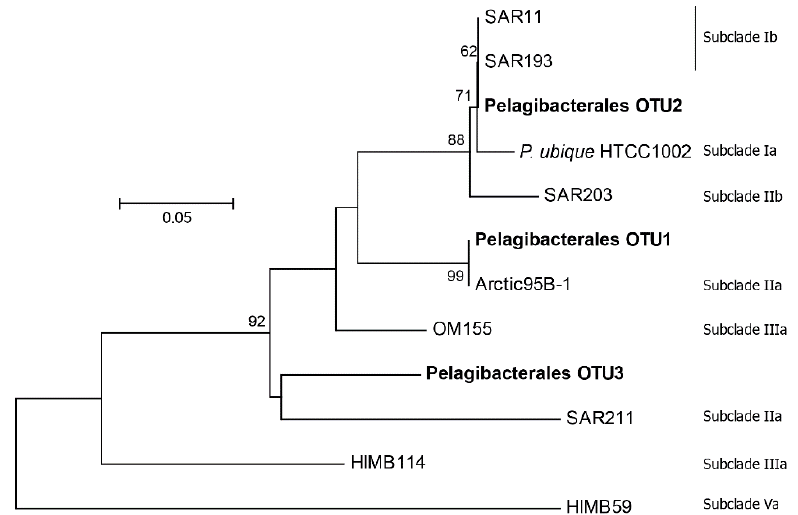
Figure 7. Phylogenetic analysis of Pelagibacterales sequences. The phylogenetic positions of the OTUs identified in our study (OTU1, 2 and 3, in bold) are shown with respect to representative sequences (with original sequence designations) from SAR11 ecotype subgroups (labelled on the right). The tree was constructed with the neighbor-joining method and 1000 bootstrap replicates, with bootstrap values > 60 shown at the nodes. The scale bar indicates substitutions per site. Details for the reference sequences are provided in Table S1.